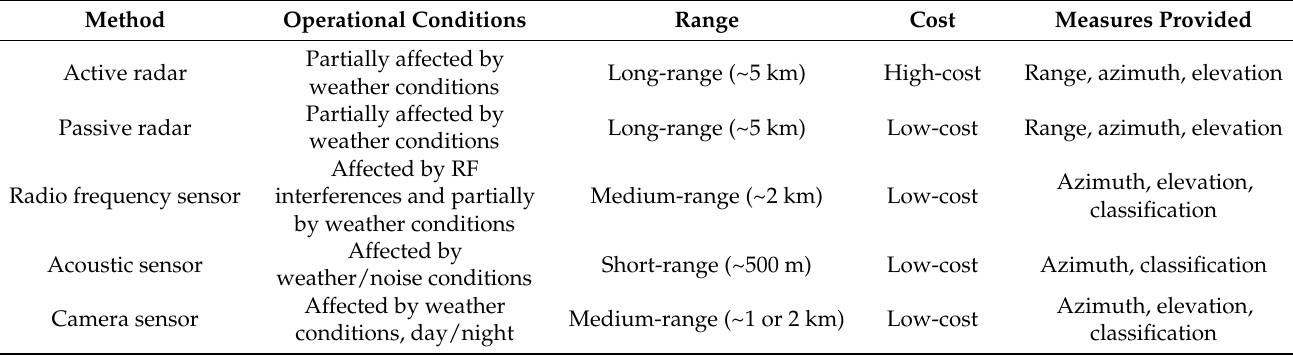
Table 14. Comparison of UAV sensing technologies.